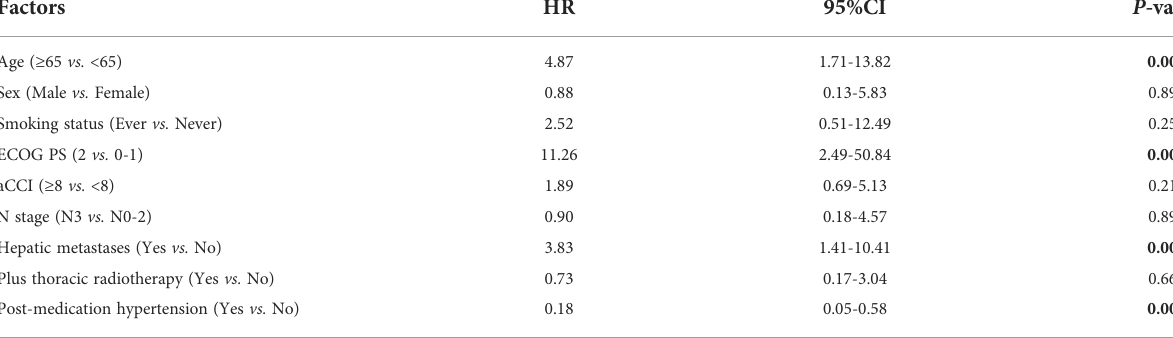
TABLE 4 Multivariate Cox regression analysis of factors associated with